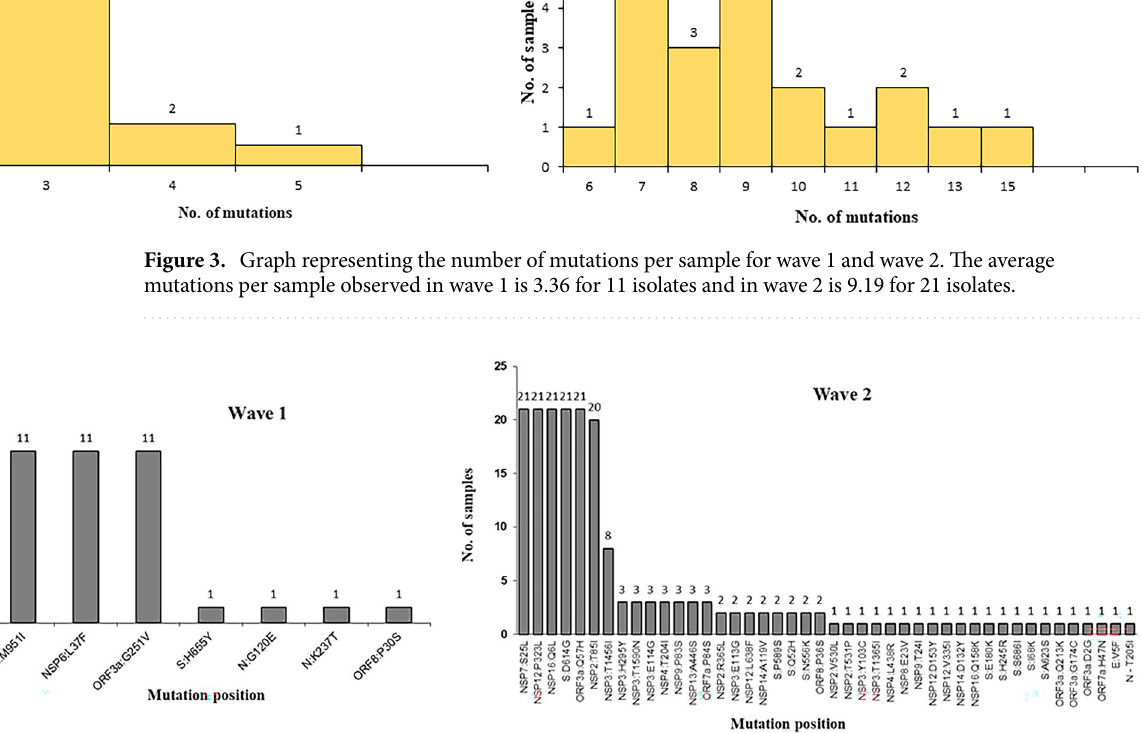
Figure 4. Graph representing the number of protein level alteration observed in first and second wave